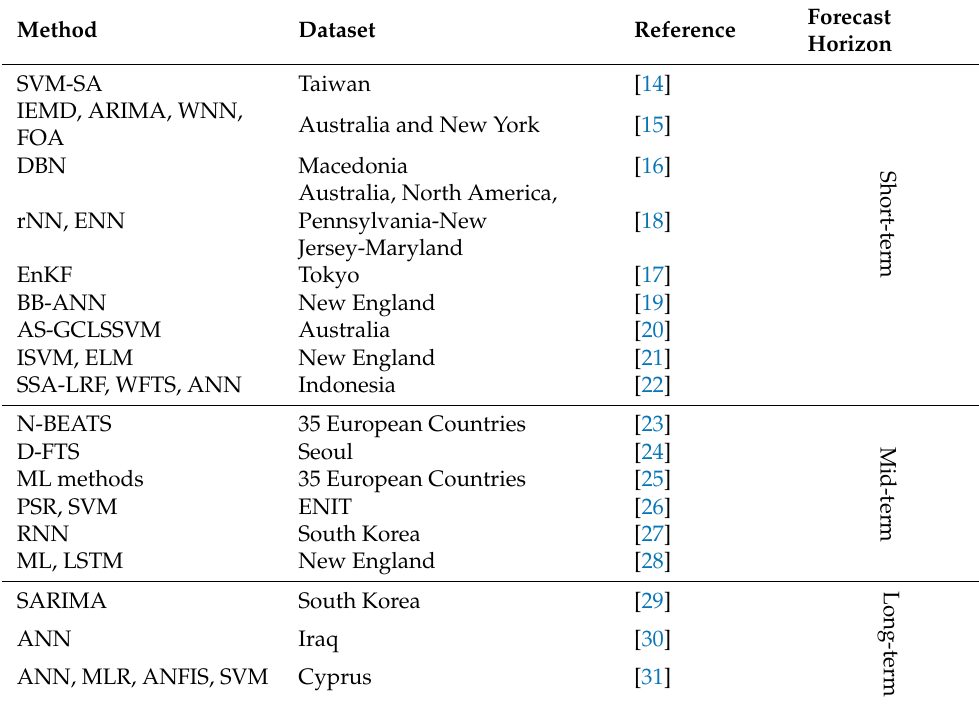
Table 1. Brief representation of some recent studies in forecasting electricity